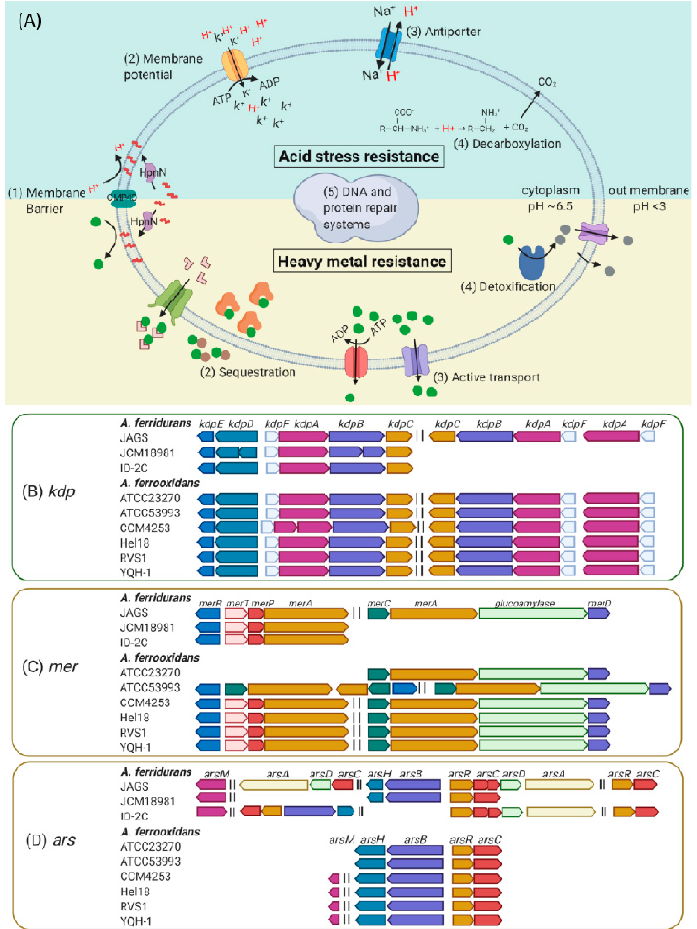
Figure 4. Overview of adaptive strategies for acid and heavy metal resistance. Potential resistance mechanisms ( A ) and comparisons of operons for kdp ( B ), mer ( C ) and ars ( D ) genes among Acidithiobacillus strains. Kdp , a high ‐ affinity K + transport system; mer , Hg 2+ ‐ resistant genes; ars , As 2+/3+ ‐ resistant genes. Annotation of arsenic resistance clusters included arsHBRCDA , arsHRBC , arsCDA ,